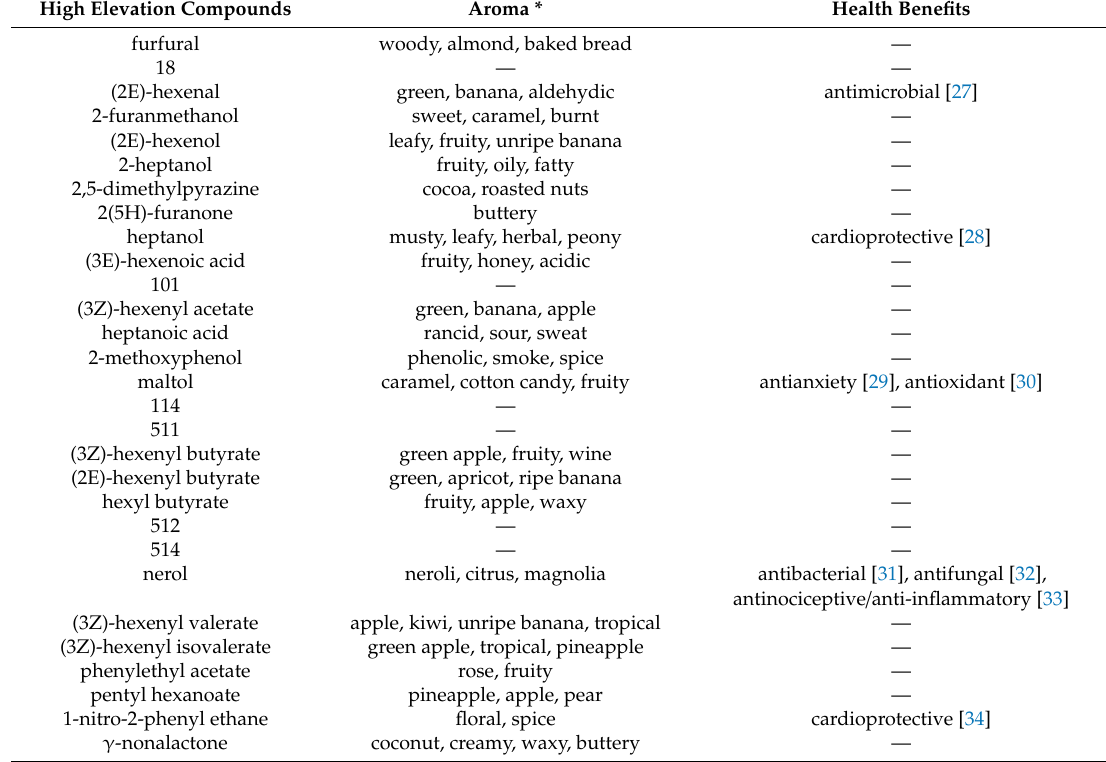
Table 2. Unique compounds in high and low elevation pu-erh tea and their sensory active and / or health beneficial